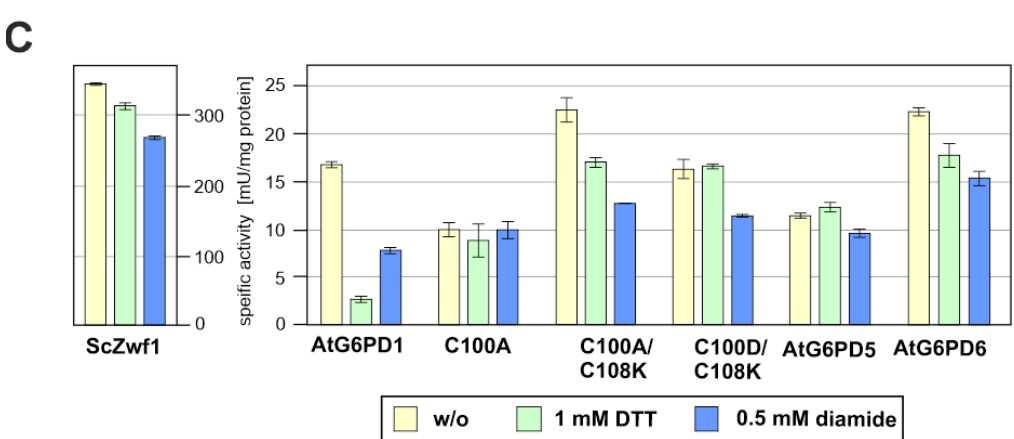
Figure 4. Analysis of a yeast zwf1 deletion producing different G6PD isoforms from Arabidopsis thaliana . ( A ) Logarithmically growing cultures of strain HOD269-1C ( zwf1::kanMX ) carrying either the wild-type AtG6PD1 gene or the mutated variants indicated on a CEN/ARS vector were subjected to drop dilution assays and analyzed as explained in the legend of Figure 2. Strains carrying the empty vector or a plasmid with the native ScZWF1 gene were employed as controls. ( B ) Western blot of crude extracts from strains producing the indicated AtG6PD isoforms. Antisera and quantification were as explained in the legend of Figure 1C, setting the amount of ScZwf1 to 100%. ( C ) Sensitivity of di ff erent G6PD enzymes produced in the yeast zwf1 deletion strain towards reductive (DTT) and oxidative (diamide) conditions. Specific enzyme activities were either directly determined after preparation of crude extracts (yellow columns) or after pre-treatment of the same crude extracts with 1 mM DTT (green columns) or 0.5 mM diamide (blue columns). Activities were at least determined in triplicate, with the error bars giving the standard deviations of these technical